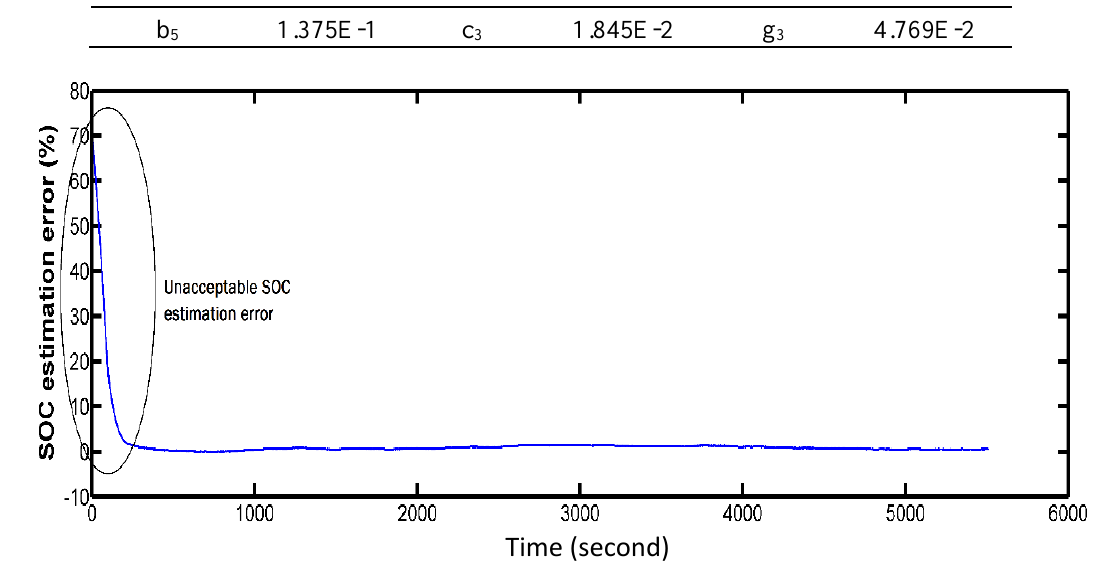
Figure 3. The MAEKF algorithm in a block diagram. Table 2. Differing impedance parameters for an aged cell as it ages.